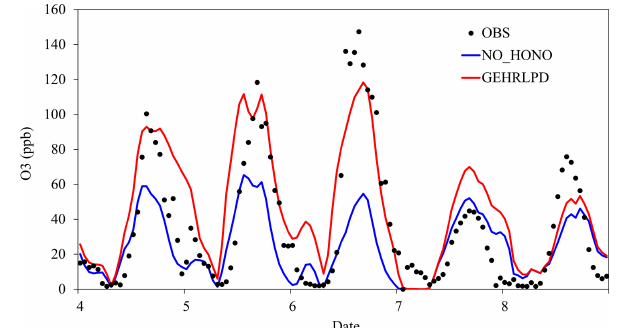
Figure 6. Temporal variation of observed and simulated O 3 mixing ratios in the NO_HONO and GEHRLPD cases at the Heshan site during 4–8 January